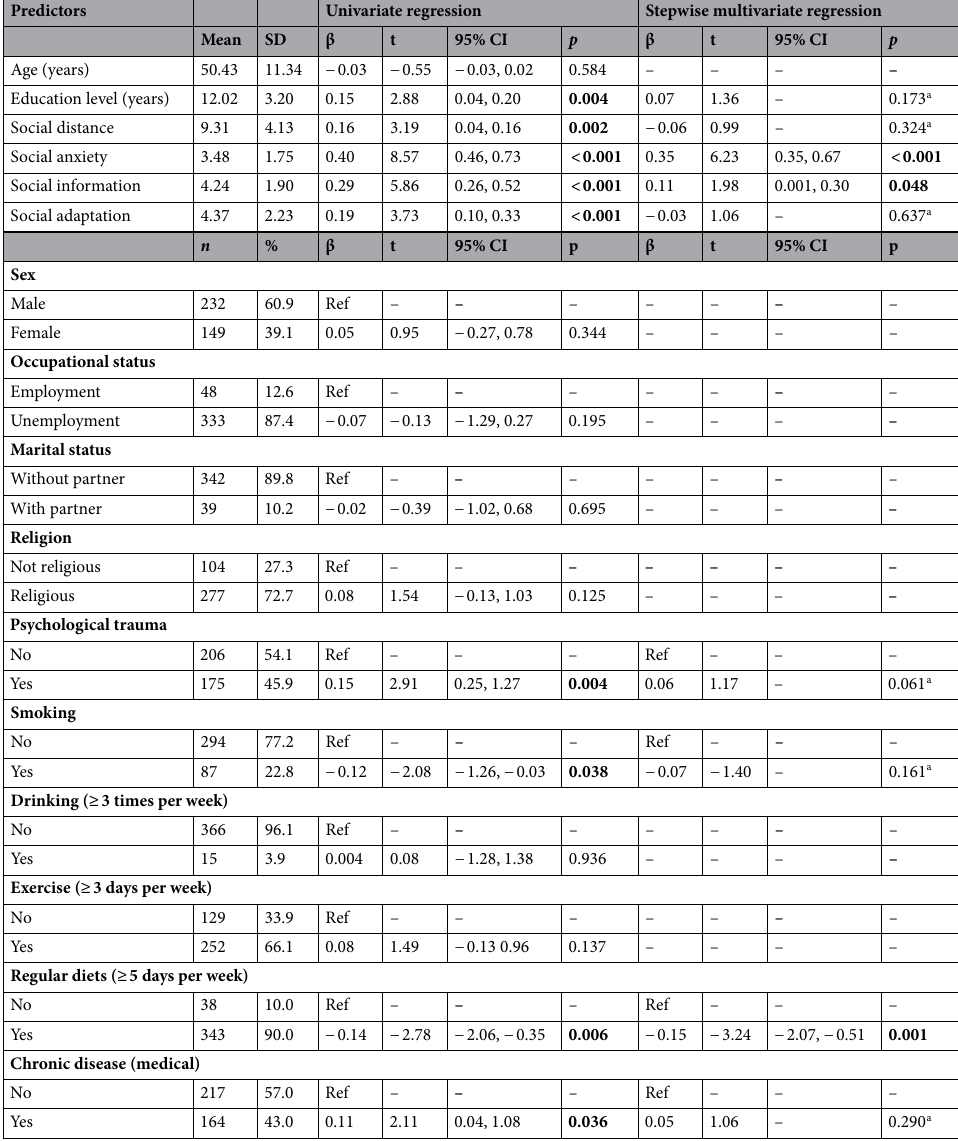
history of psychological trauma, chronic disease, and those who did not smoke. The final model indicated that the following factors were considered significant: social anxiety (β = 0.35; P < 0.001), social information (β = 0.11; tion was excluded from the bootstrapping analysis. The remaining factors that were examined by bootstrapping regression were social anxiety and subjects without regular diets (Supplementary Table S6). Tests for the mediation model and estimated co‑efficient paths. The correlation matrix among variables is demonstrated in Table 3. In addition, the Table 4 showed the factor loadings through confirmatory factor analysis (CFA) and the result of the reliability test, which indicated an acceptable range. The indirect and